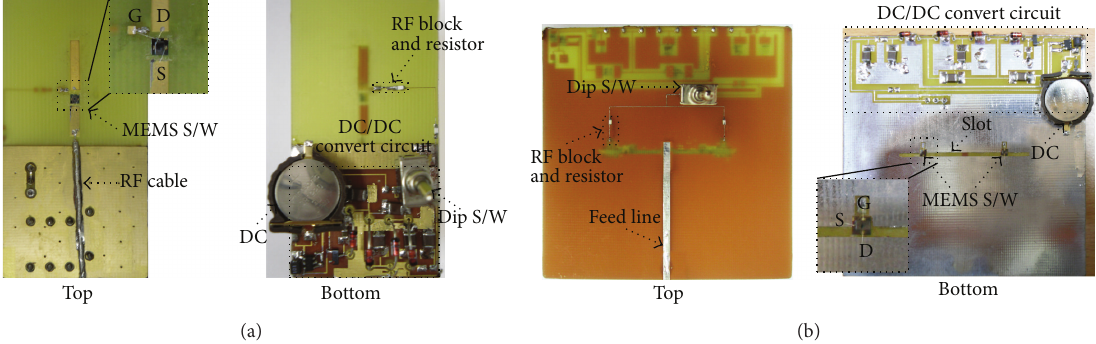
Figure 12: Photograph of the reconfigurable antennas with the MEMS switch; (a) the monopole antenna and (b) the slot antenna.